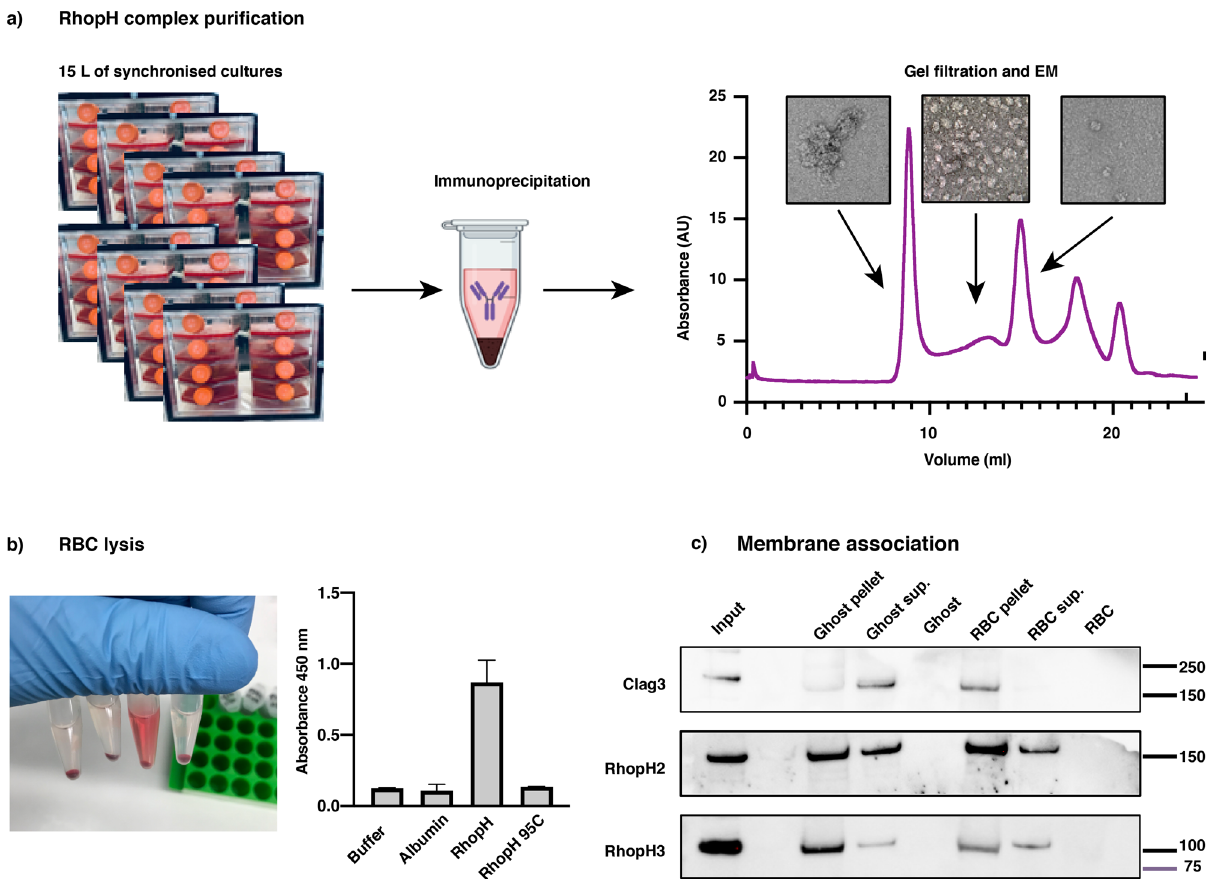
Fig. 5 Puri fi ed RhopH complex spontaneously associates with RBC membranes. a RhopH complex puri fi ed from trophozoites expressing Clag3.1-Flag using an anti-Flag resin. Eluates were further puri fi ed by size-exclusion chromatography and analysed by negative-stain electron microscopy and mass spectrometry (left panel). b RhopH complex added to human erythrocytes resulted in lysis and haemoglobin release. This lysis activity was abolished if the protein was denatured for 5 min at 95 °C. Quanti fi cations from three independent replicates. c Puri fi ed RhopH complex can associate with human erythrocytes and ghost membranes. Full blots shown (Supplementary Fig.